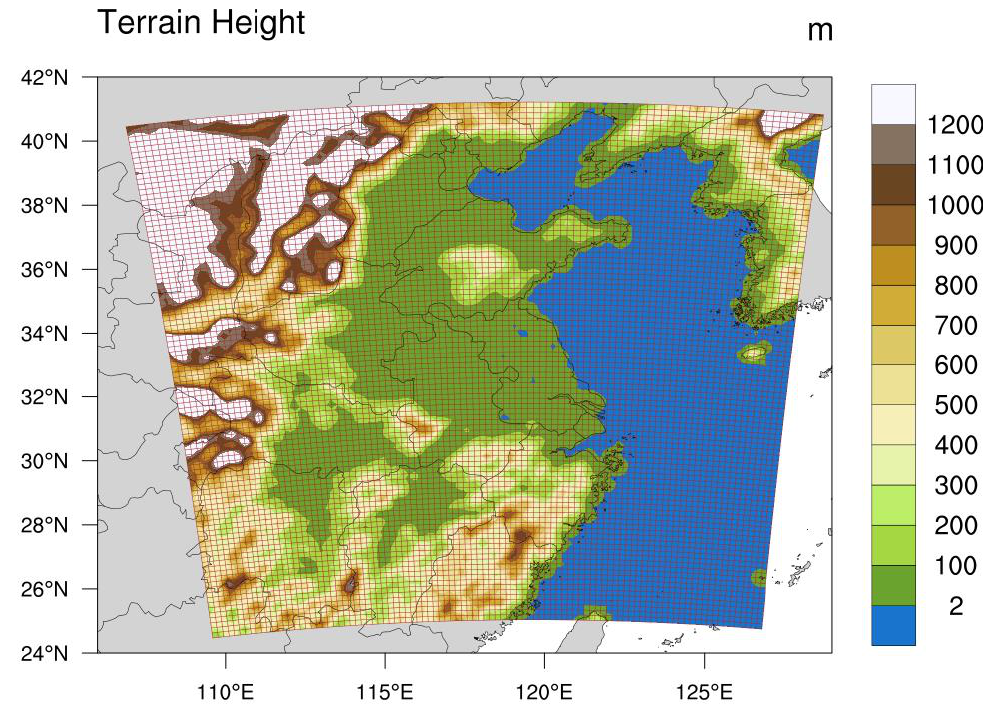
Figure 1. Simulation domain in WRF-Chem (the grid interval is 18 km).